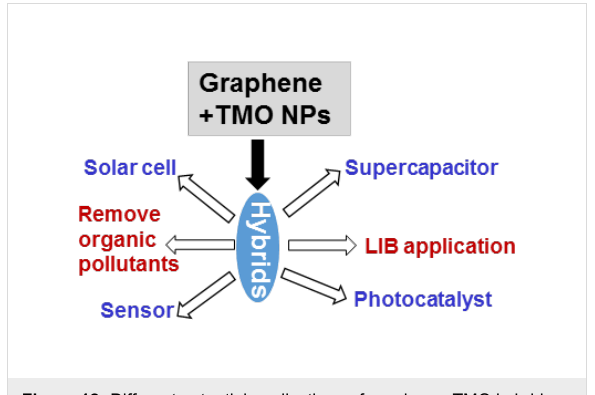
Figure 12: Different potential applications of graphene–TMO hybrid